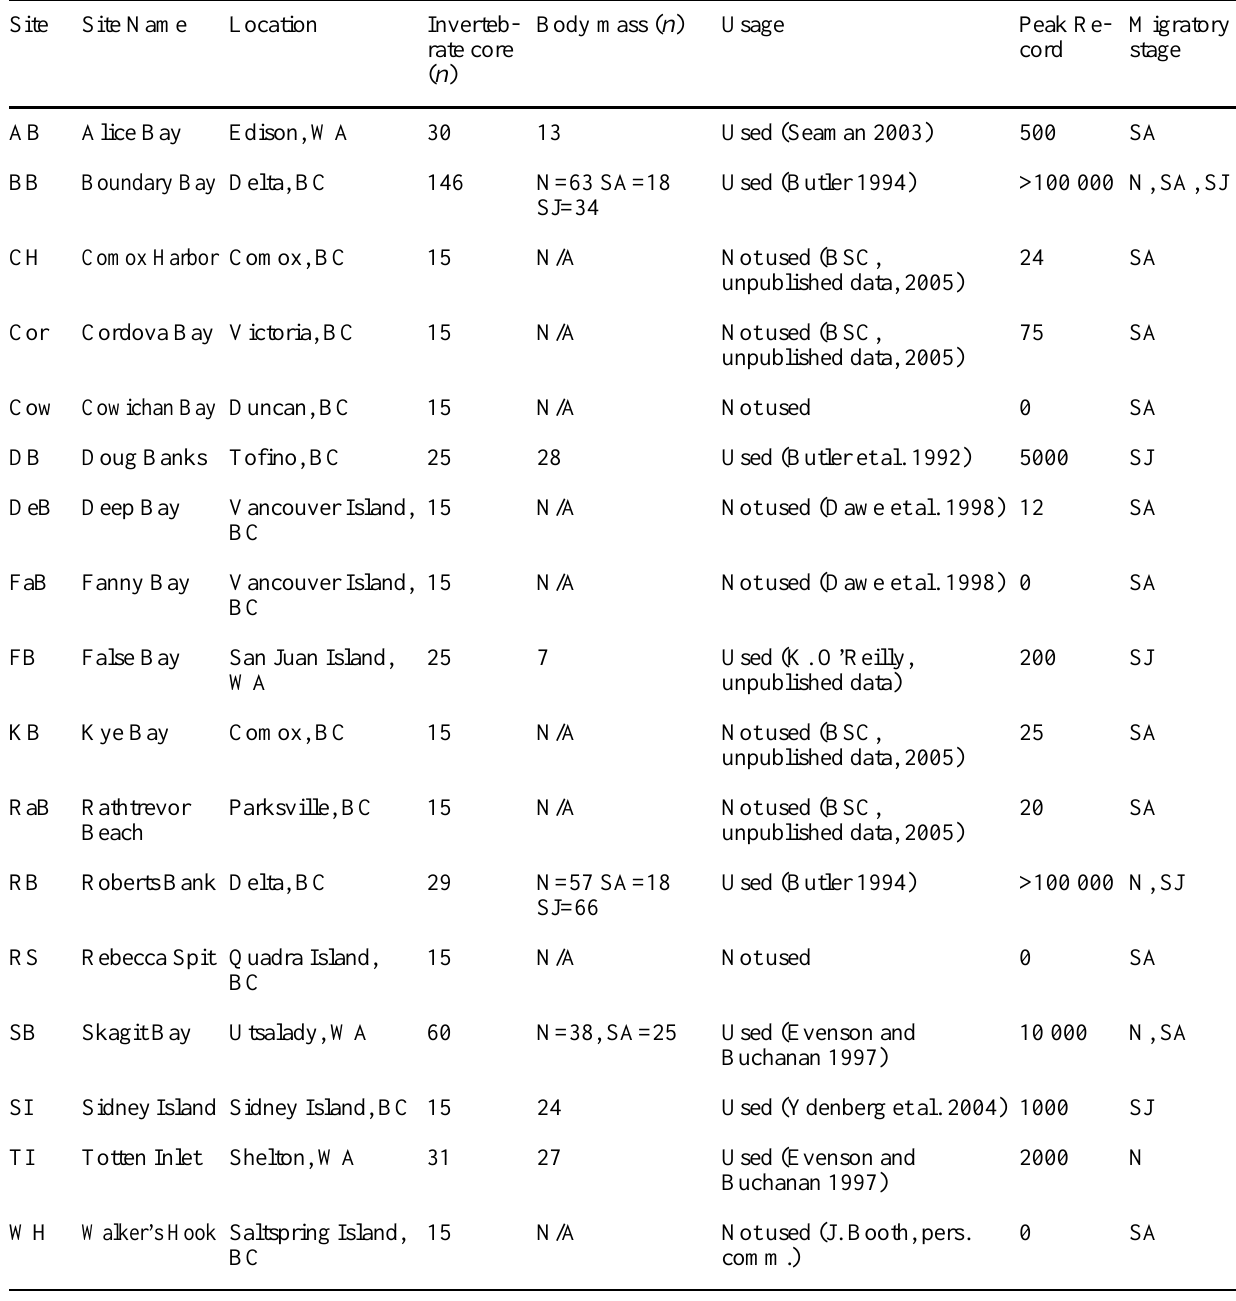
Table 1. The name and location of stopover sites sampled in the Georgia Basin/Puget Sound region, sample sizes for invertebrate cores and body-mass samples, and usage data for each migratory stage (N = northward, SA = southward adult, SJ = southward juvenile, n =